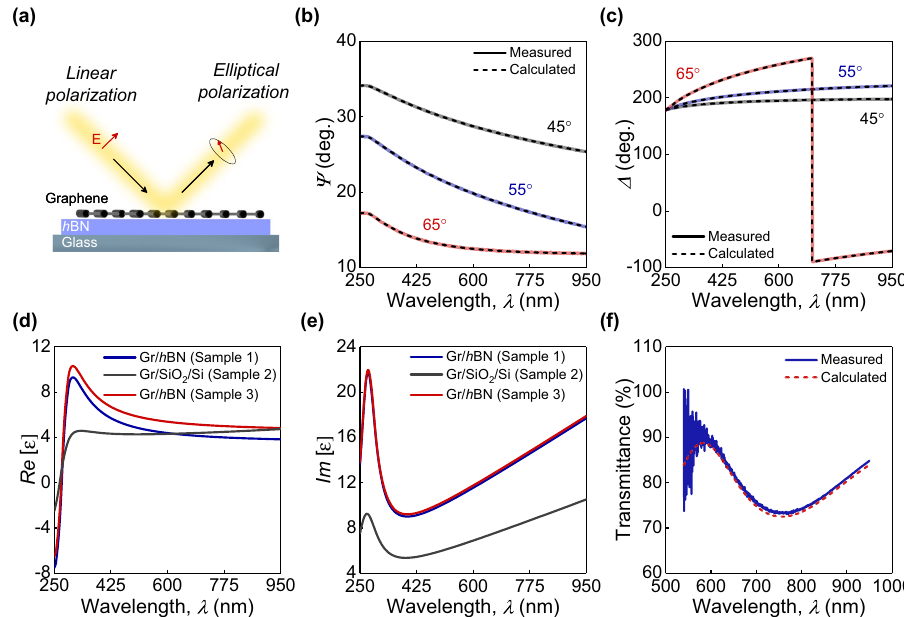
Fig. 2 Imaging spectroscopic ellipsometry of monolayer graphene on h BN/glass substrate. a Schematic illustration of the measurement setup. Ellipsometric parameters Ψ ( b ) and Δ ( c ) at three incident angles 45°, 55°, 65°. Solid (dashed) lines represent the measured (evaluated) cases. Real ( d ) and imaginary ( e ) parts of the obtained dielectric function. Gray lines correspond to real and imaginary parts of dielectric function obtained for monolayer graphene on SiO 2 /Si substrate. Drude – Lorentz oscillators parameters are collected in Supplementary Table 1. f Micro-transmittance spectra of graphene on h BN/glass substrate. Solid (dashed) line represents the measured (evaluated)